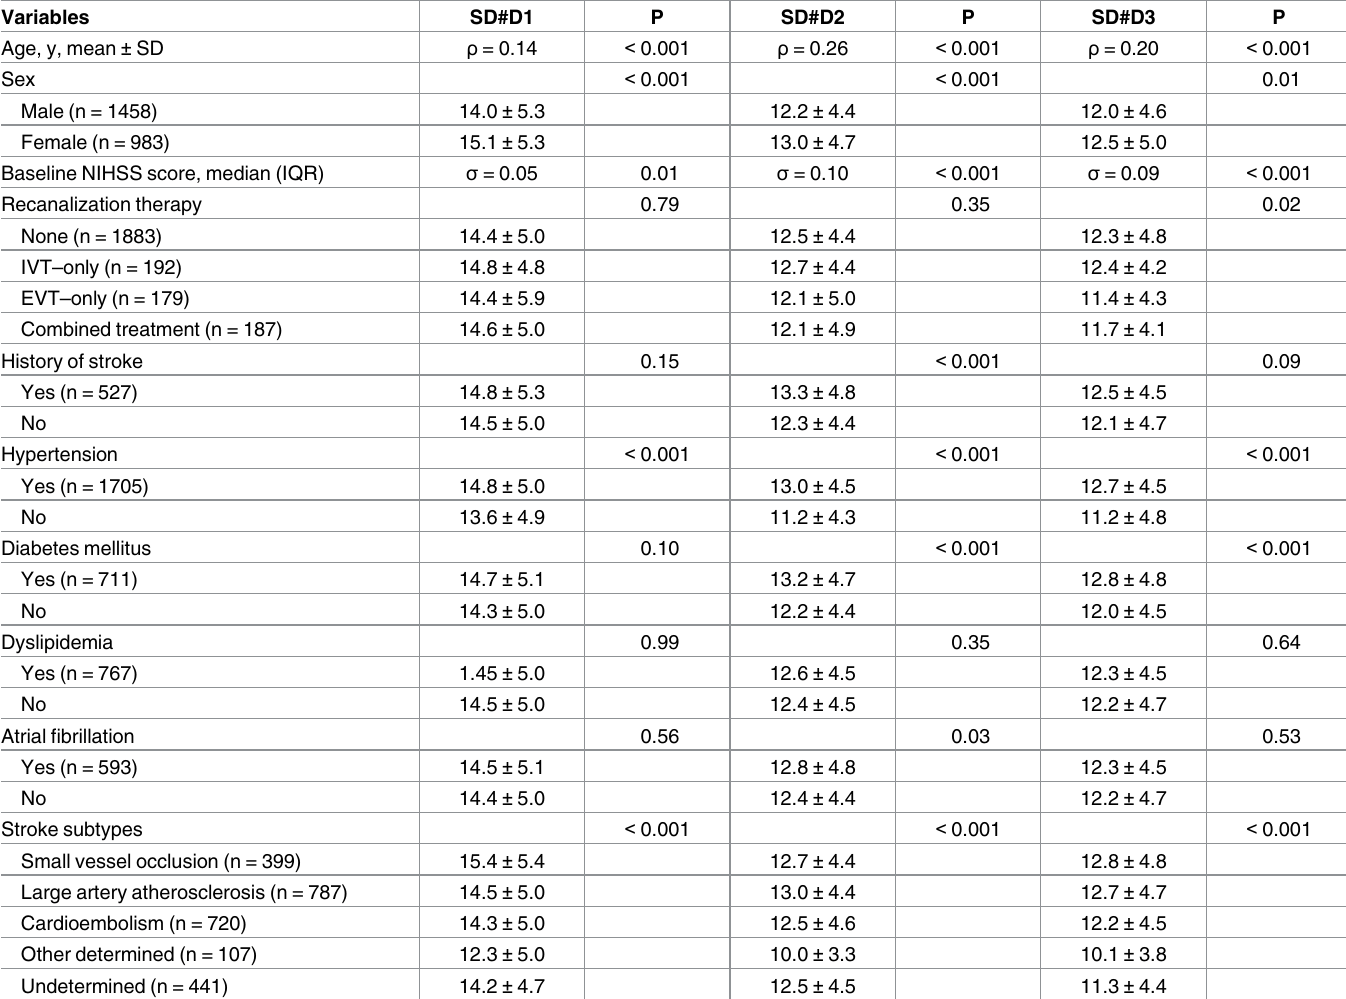
Table 1. Association of baseline characteristics with daily SBP SD